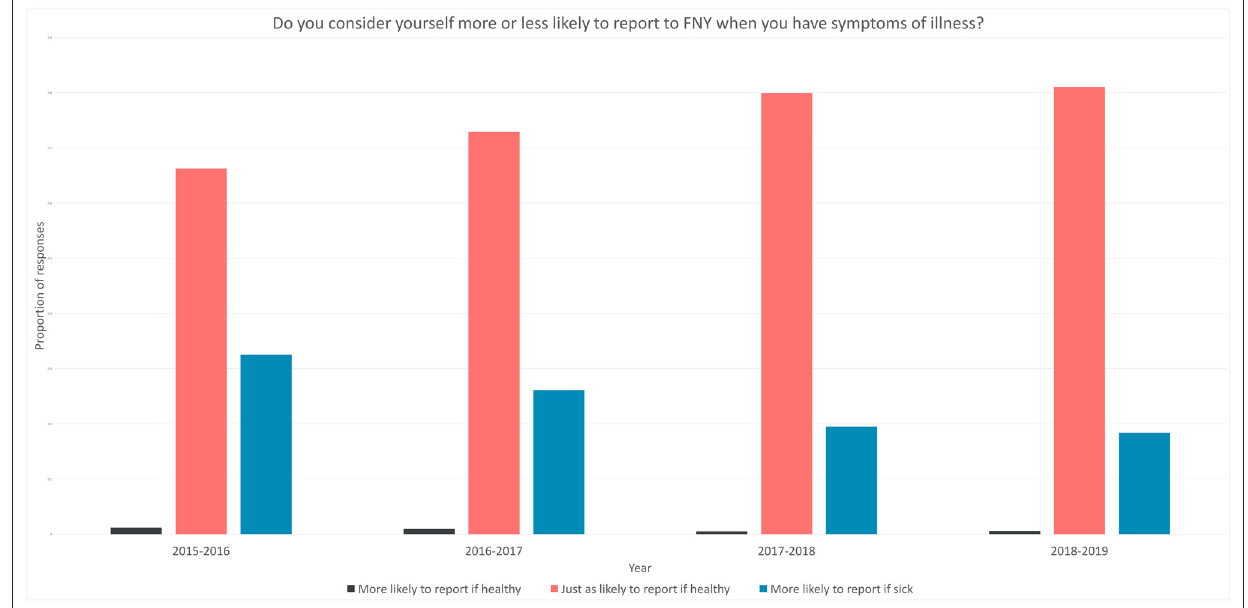
Figure 4 Proportion of responses to the survey question “Do you consider yourself more or less likely to report to FNY when you have symptoms of illness?” by influenza season. FNY: Flu Near